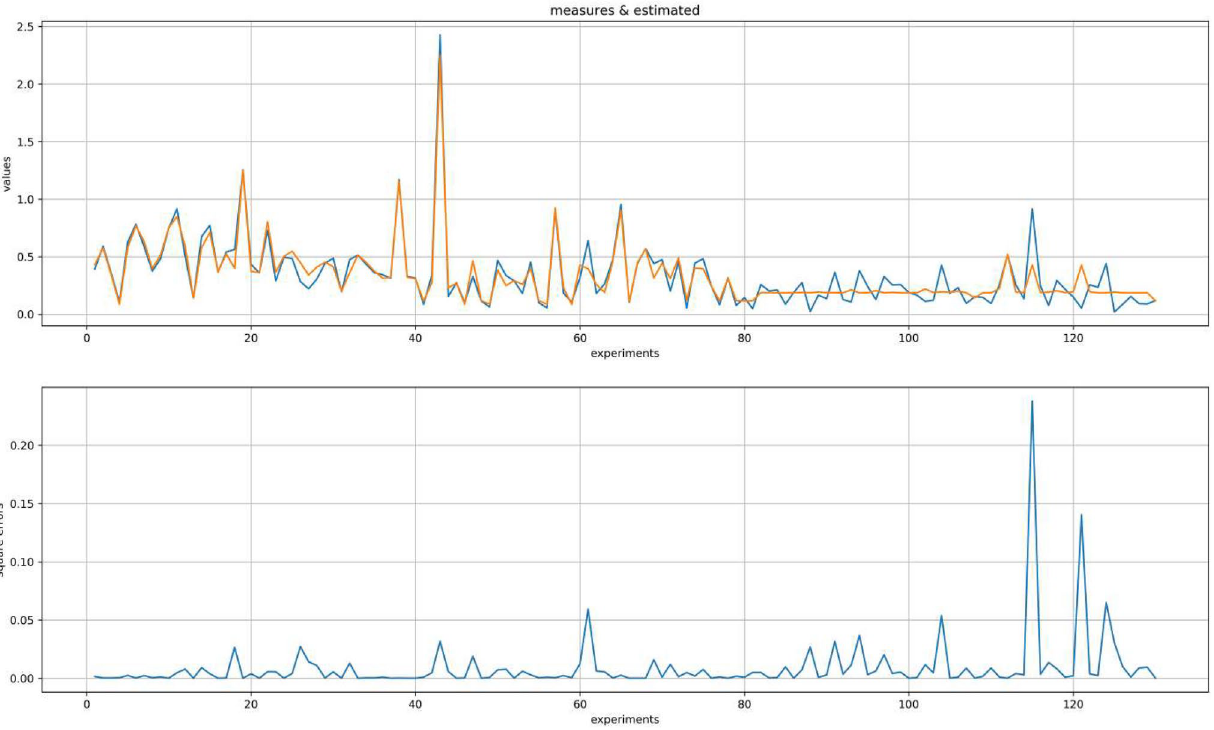
Figure 7. Fitting data with the top panel showing the Euclidean distance values observed from the participants’ productions in blue and estimated by our clock model in orange with time t . The second panel shows the paired square errors